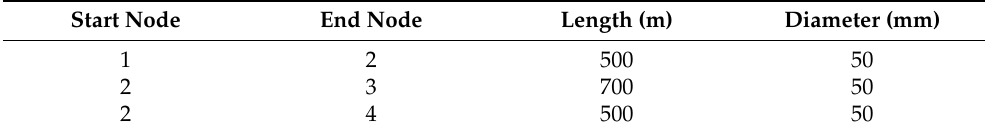
Figure 4. Integrated simulation platform for the test system. Table 1. Parameters of the gas network.